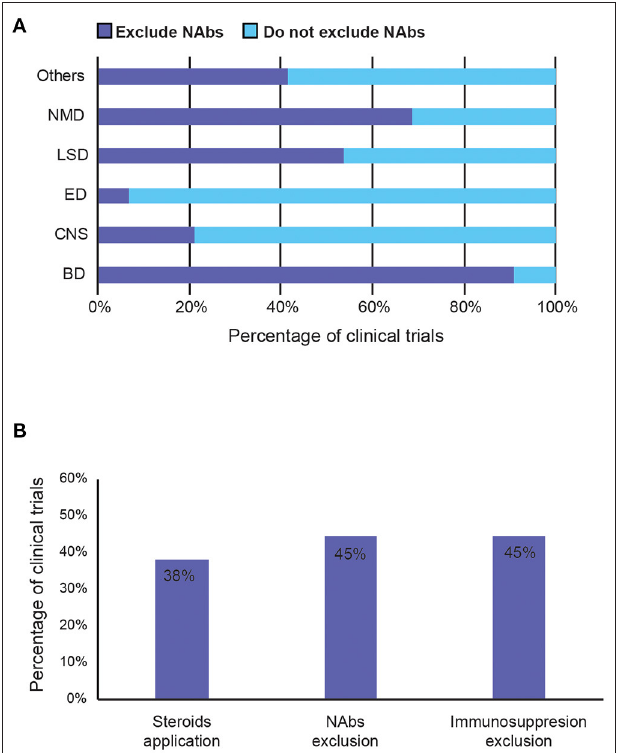
FIGURE 7 | Summary of strategies to avoid immunogenicity induced by AAV vector in clinical trials. (A) Percentage of trials that exclude patients with pre-existing anti-capsid NAbs by therapeutic area. (B) Percentage of trials that reported (1) potential use of steroids during the study period, (2) exclude patients with pre-existing anti-AAV capsid neutralising antibodies (NAbs), and (3) exclude immunosuppressed patients (such as those with concurrent use of immunosuppressants or with immunosuppressive disorders). BD, Blood disorders; CNS, Central Nervous System; ED, Eye Disorders; LSD, Lysosomal storage disorders; NMD, Neuromuscular Disorders.